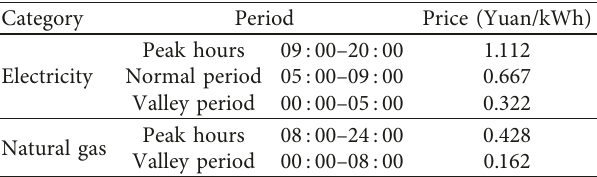
Table 3: Energy purchase prices.